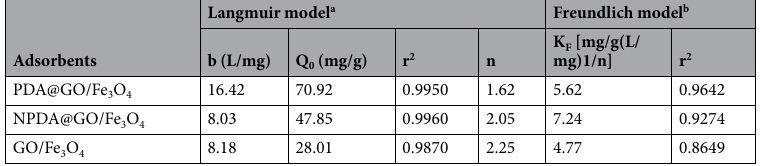
(2) where q e and q m were the e